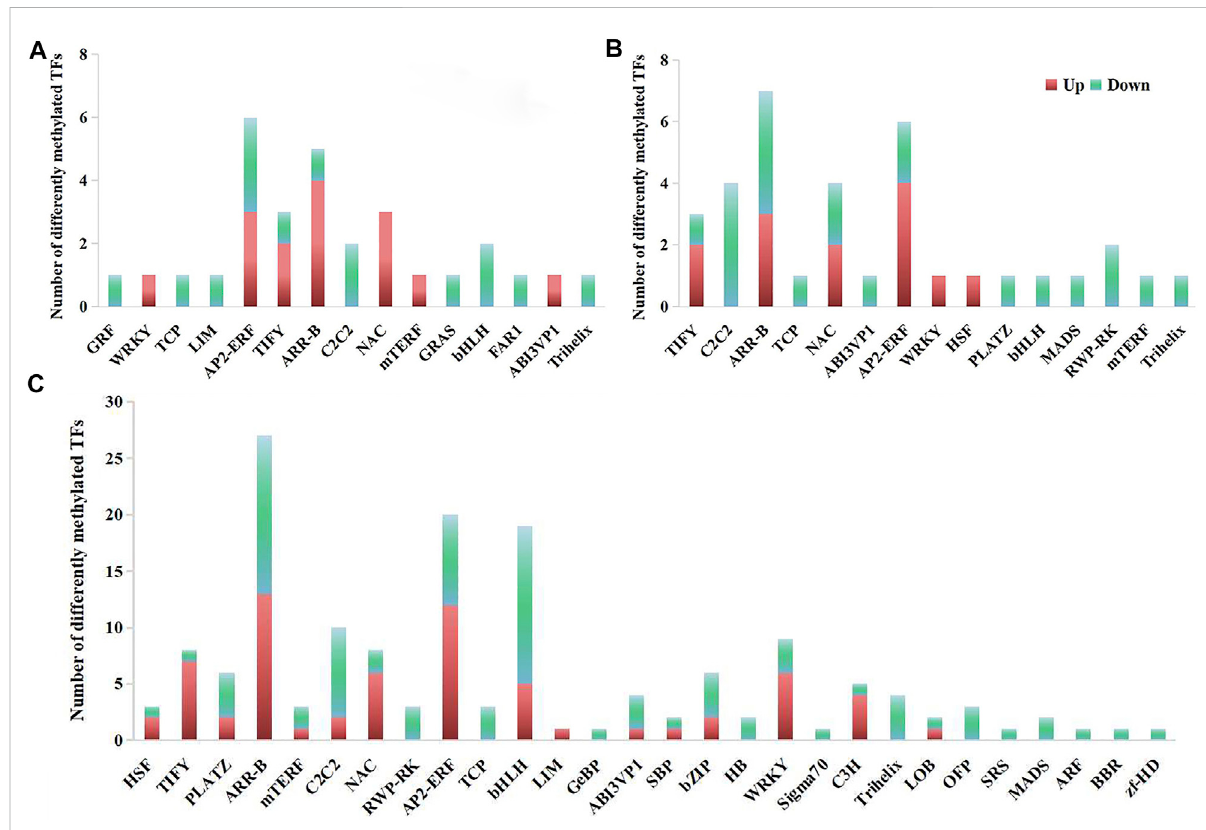
FIGURE 6 Classi fi cationofdifferentiallymethylatedTFsinwinterrapeseedNS. (A) ,TFsidenti fi edinsequencecontextofCG; (B) ,TFsidenti fi edinsequence context of CHG; (C) , TFs identi fi ed in sequence context of